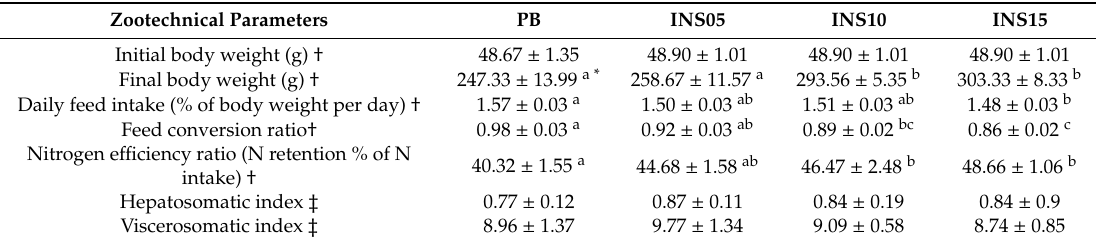
Table 1. Growth and feed intake data for trout fed plant-based (PB) diet or diets with increasing amounts of insect ingredient (INS05, INS10 and INS15) for 84 days. Mean ± standard deviation. n = 3 tanks with 30 fish in each tank, or n = 9 fish for each